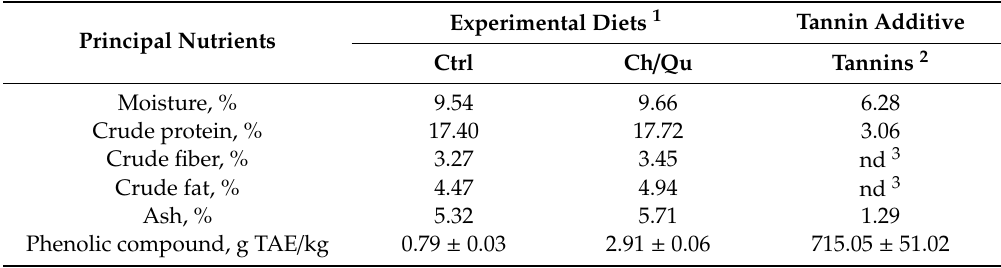
Table 2. Chemical analysis of experimental diets fed to piglets from day 0 to day 40 1 of the in vivo trial (from 35- to 75-day-old